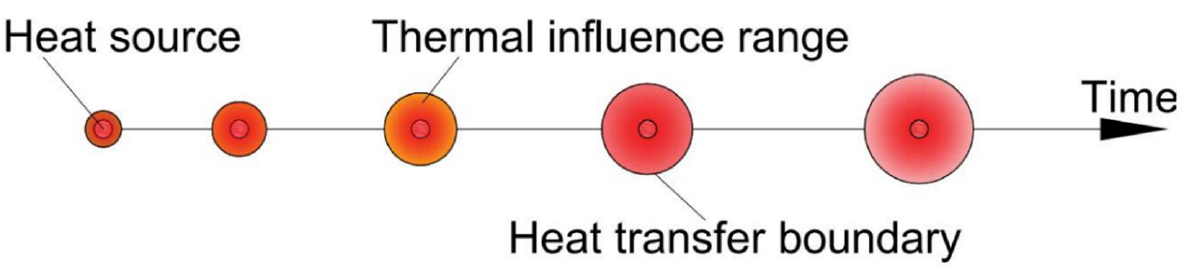
Figure 4. Schematic diagram of the heat transfer process.